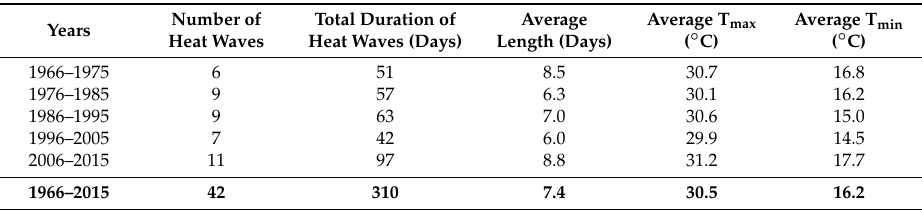
Table 2. Characteristics of heat waves in 1966–2015 in Pozna ń – Ł awica.